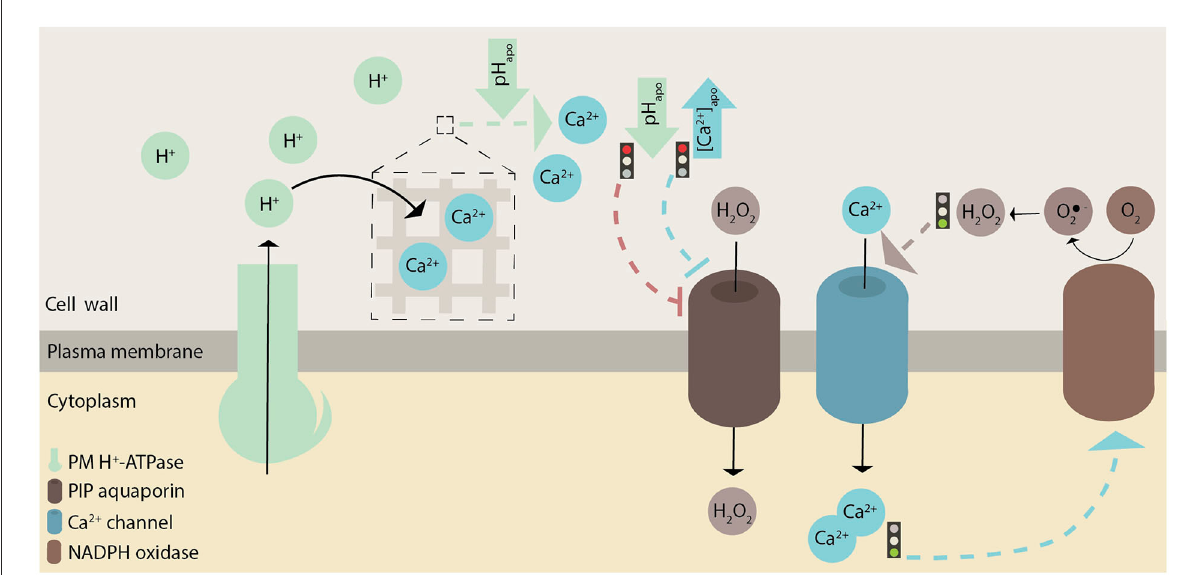
FIGURE4 Graphical illustration of how pH, ROS, and Ca 2 + possibly interact with each other in root hairs. These hypothesized interactions are indicated with dashed lines. In general, green represents pH, brown ROS, and blue Ca 2 + -related effects or proteins. Whether there are causative links between H + and Ca 2 + fluxes remains to be